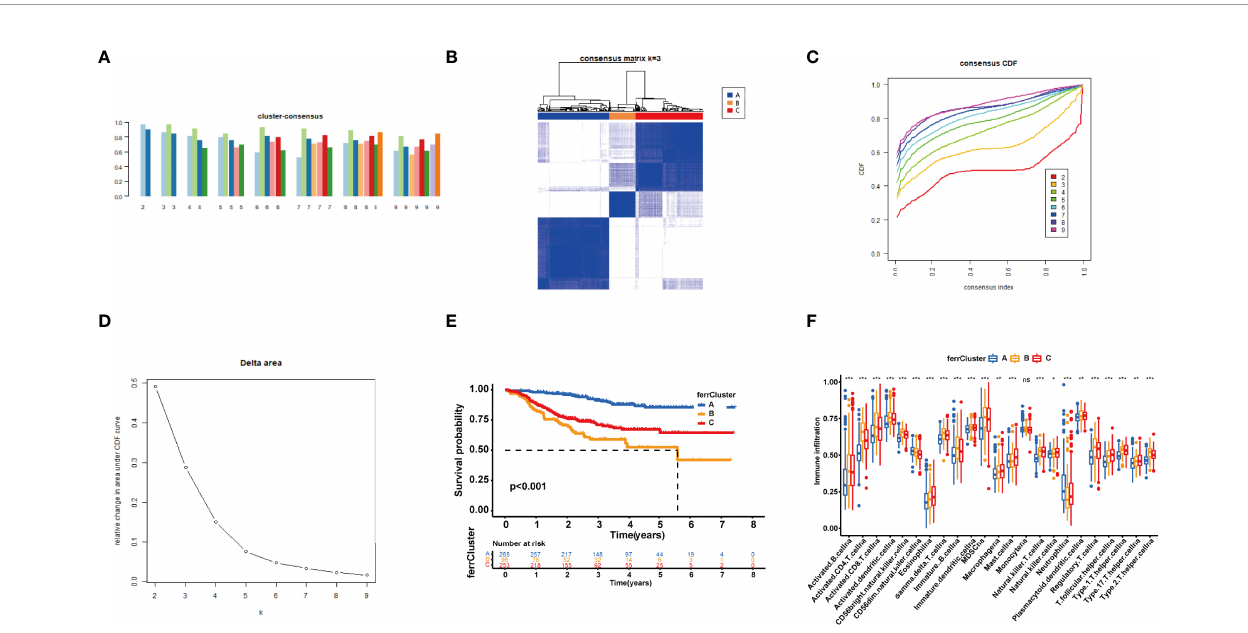
FIGURE 6 | Consensus clustering of 18 ferroptosis-related genes (FRGs) identi fi ed three clusters of patients. (A) The tracking plot for k = 2 to k = 9. (B) The heatmap for K = 3. (C) Consensus clustering cumulative distribution function (CDF) with k = 2 to k = 9. (D) Relative change in area under CDF curve for k = 2 – 9. (E) Kaplan – Meier (K-M) curve of the survival difference among clusters 1 – 3. (F) Single-sample gene set enrichment analysis of immune status among three ferrClusters. ns, P>0.05. *, P < 0.05; **, P < 0.01; ***, P <